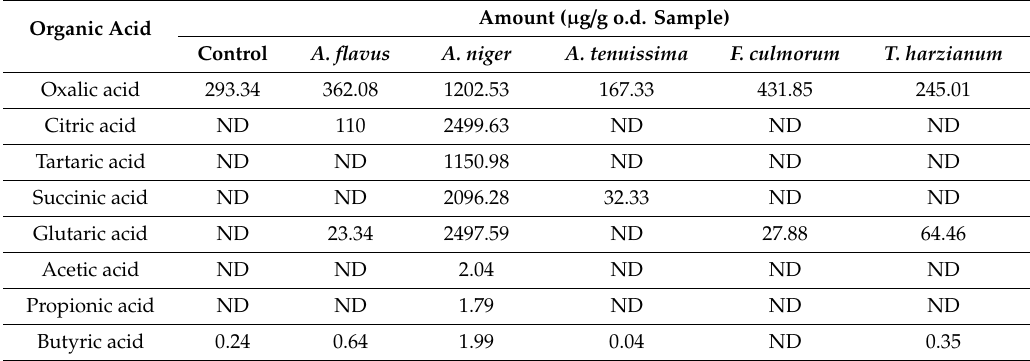
Table 2. High-performance liquid chromatography (HPLC) analysis of wood organic acids as a ff ected by growing five